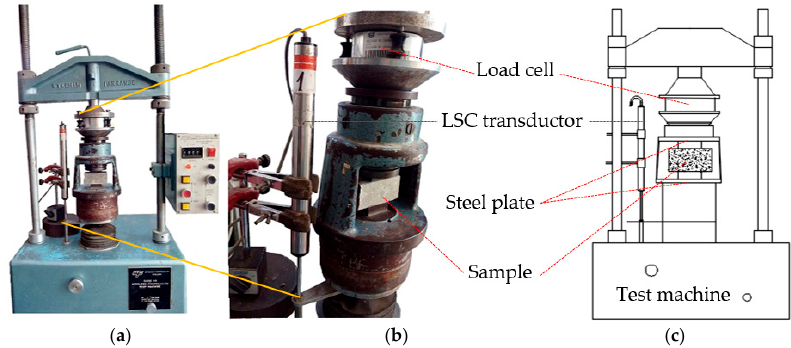
Figure 3. ( a ) General configuration of the experimental arrangement; ( b ) detail of LSC; and ( c ) idealized scheme from set.